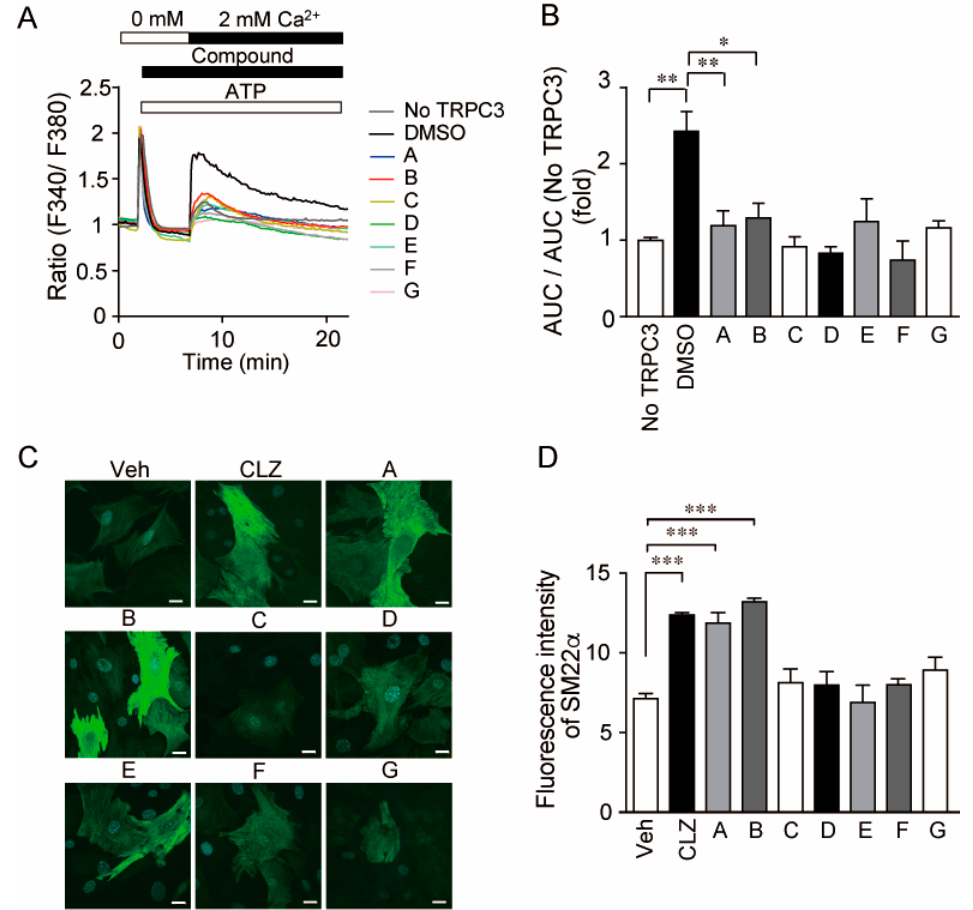
Figure 3. 1 Effects of TRPC3/6 channel inhibitions on TRPC3-mediated Ca 2+ influx and VSMC